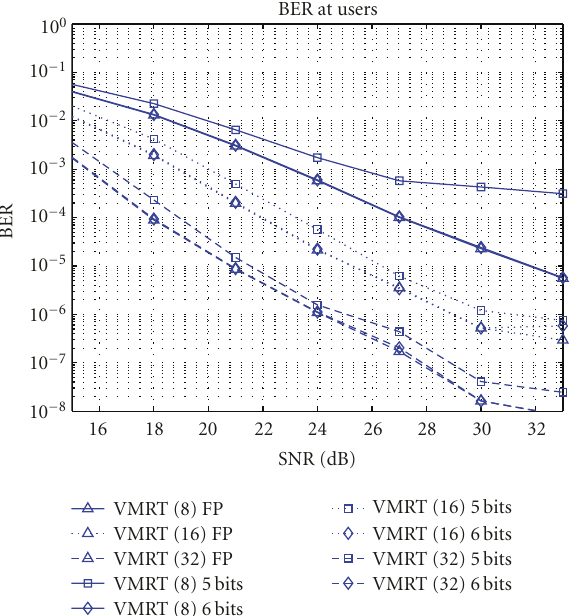
Figure 6: Performance results for Uncoded 64QAM. E ff ect of the quantization on the VMRT. N T = 4, N RS = 8, and N VMRT = 8,16,32. full precision (FP) and the number of bits for